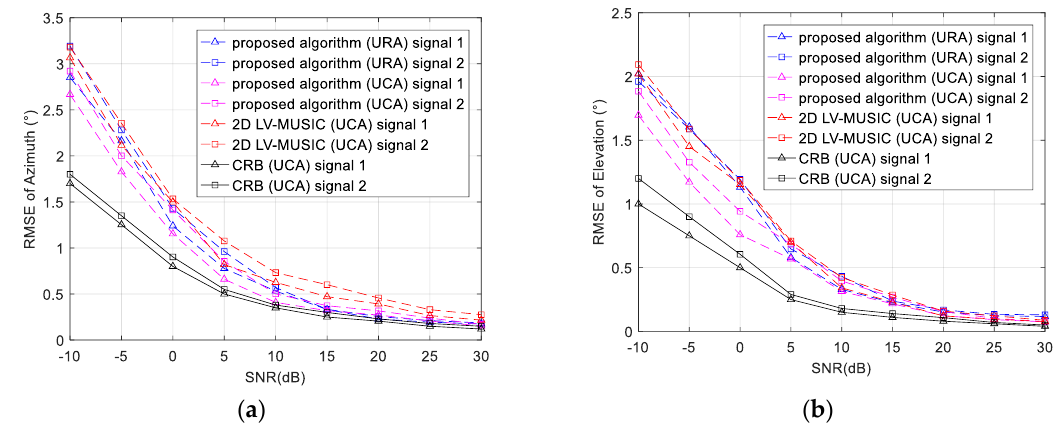
Figure 5. RMSE and CRB of ( a ) azimuth and ( b ) elevation versus SNR (for 300 snapshots).